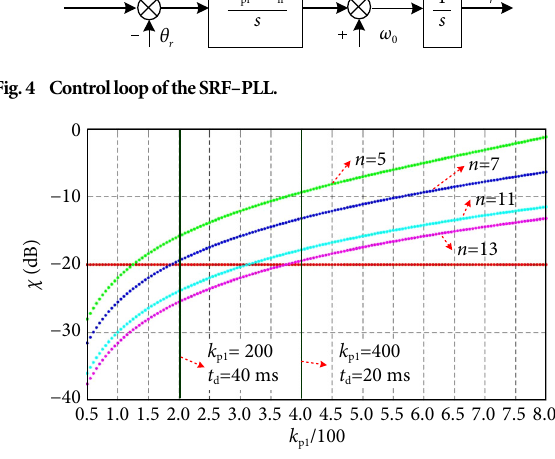
Fig. 5 Relationship between the attenuation gain χ for high-order harmonics and k p1 when PO is fixed at 0.2.